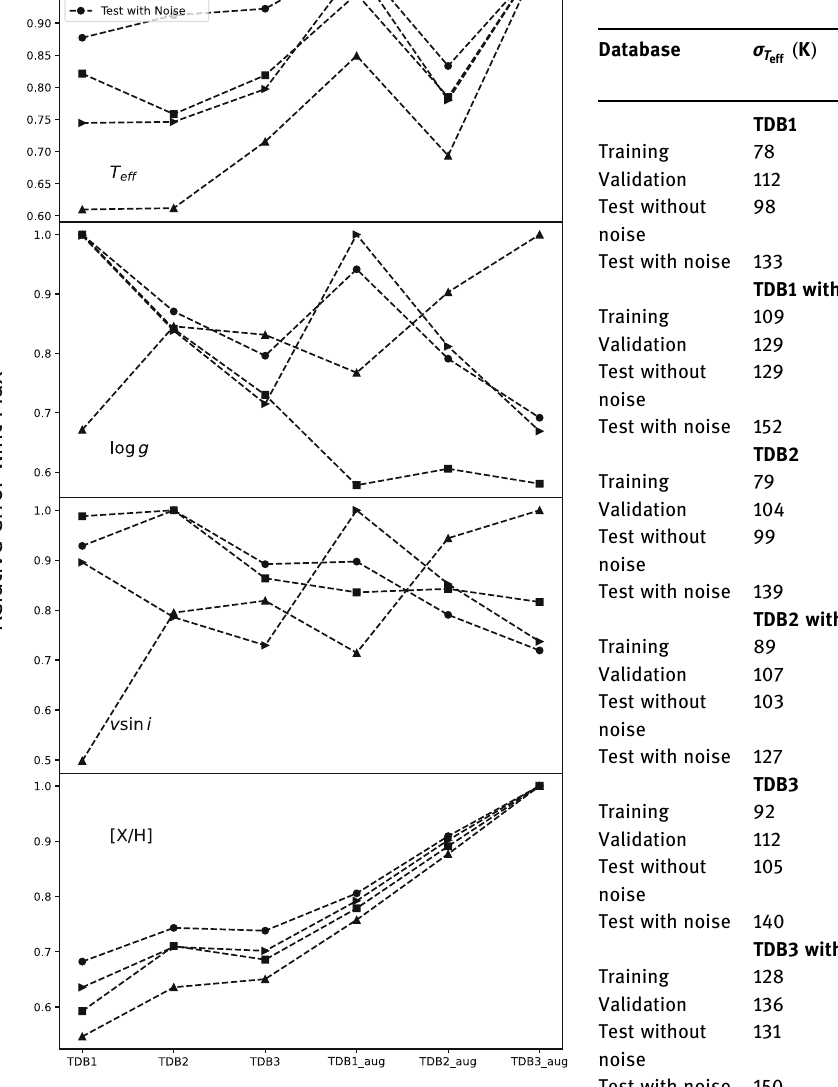
Table 3: Derived standard deviation for each parameter using TDB1, TDB2, and TDB3 with and without data